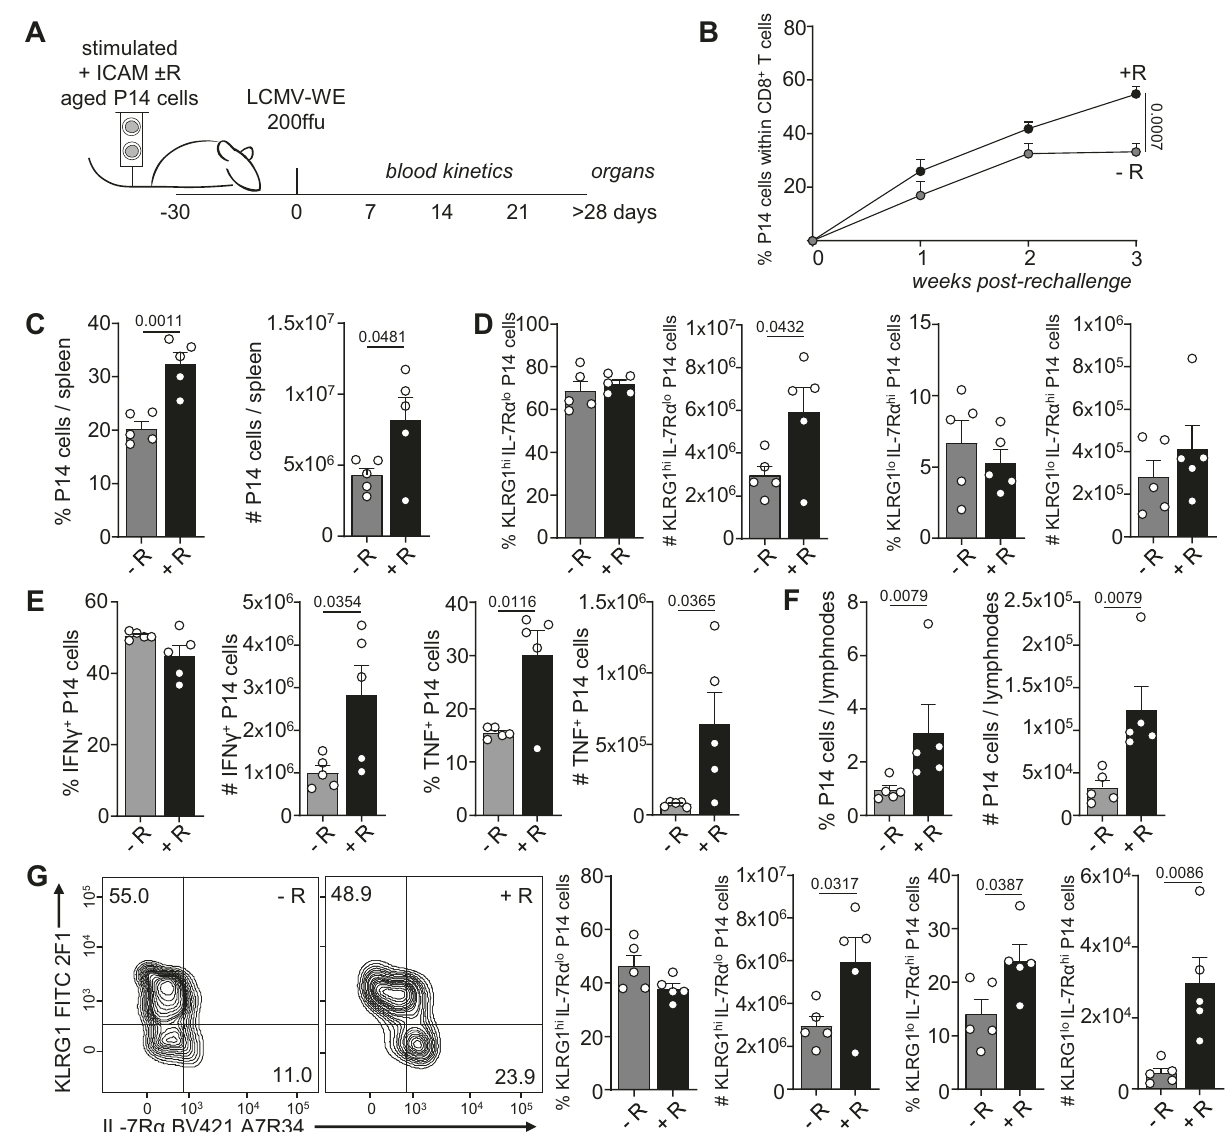
Fig. 2 Re-establishment of asymmetric cell division in CD8 + T cells from aged mice correlates with increased memory potential. A Experimental setup (illustration by MB). Naive P14 cells from aged mice were stimulated in vitro on α -CD3, α -CD28 and human Fc-ICAM-1 coated wells in presence or absence of transient rapamycin (R) treatment, harvested after 36 h, and adoptively transferred into young and naive wild-type recipients. Each recipient mouse received 1 × 10 4 cells and was infected intravenously with LCMV-WE > 30 days later. B Frequencies of P14 cells within the CD8 + T-cell population in the blood. C Frequency and numbers of adoptively transferred P14 cells within CD8 + T cells in the spleens of recipient mice. D Frequencies and numbers of KLRG1 hi IL-7R α lo or KLRG1 lo IL-7R α hi P14 cells in the spleens of recipient mice. E Frequencies and numbers of splenic IFN γ and TNF P14 producing cells. F Frequencies and numbers of adoptively transferred P14 cells within CD8 + T cells in the inguinal lymph nodes of recipient mice. G Representative fl ow cytometry plots of KLRG1 and IL-7R α expression in P14 cells in the lymph nodes of recipient mice 30 days after LCMV-WE challenge (left panel); percentages and numbers of KLRG1 hi IL-7R α lo and KLRG1 lo IL-7R α hi P14 cells in the lymph nodes of recipient mice (right panel). Representative data ( n = 5 per group) from one out of two experiments. Aged P14 animals used for adoptive cell transfer: 95 weeks (experiment 1); 71 weeks (experiment 2). Data are depicted as mean + SEM. Statistical analysis was performed using the unpaired two-tailed Student ’ s t test ( B – E , G , week 3) or when data did not pass the normality test, the unpaired two-tailed Mann – Whitney U test ( F , G , #KLRG1 hi IL-7R α lo ). Exact P values are depicted in the fi